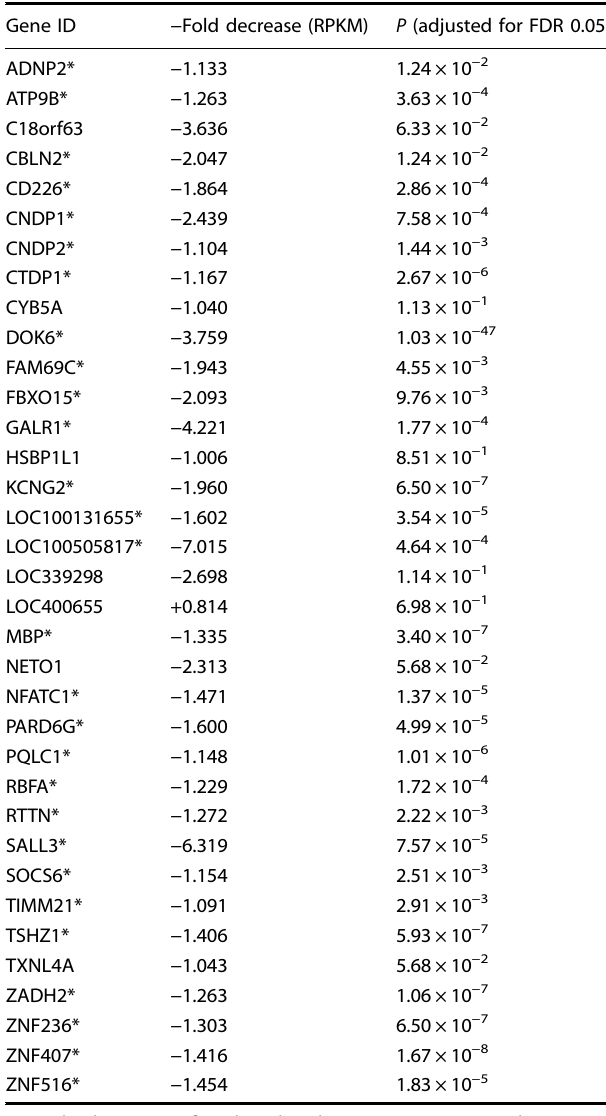
Table 1. Reduced transcription of genes telomeric to DOK6 in gastric cancer with FRA18C copy number deletion Gene